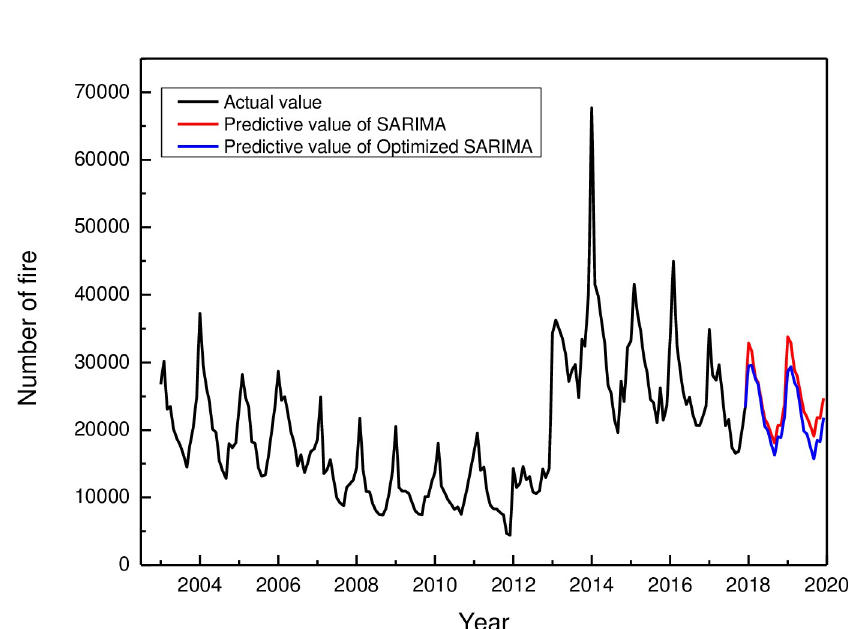
Fig 8. The predictive value of the two models. Compared with the total number of fires in 2018 and 2019 published on the website of the emergency management department, we found that the trend of the predicted data is consistent with the actual value, and is closer to the actual value than that of the original model. The comparison between the accumulated fire data of 2018 and 2019 obtained by the SARIMA model and optimized SARIMA model and the actual value is shown in Table 2. The accuracy of the predictive results in 2018 is improved by 7.6%, the predictive results in 2019 are improved by 15.4%, and the average accuracy is improved by